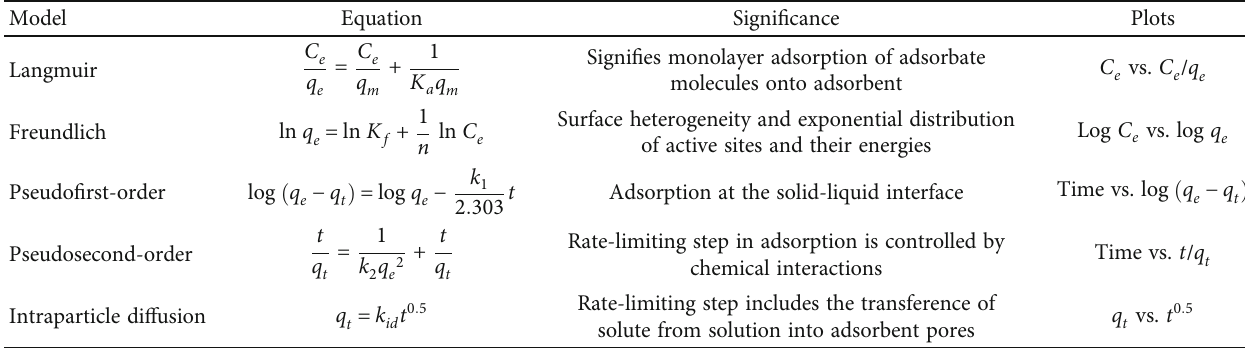
Table 2: Linear equation and signi fi cance of various isotherm and kinetic models.